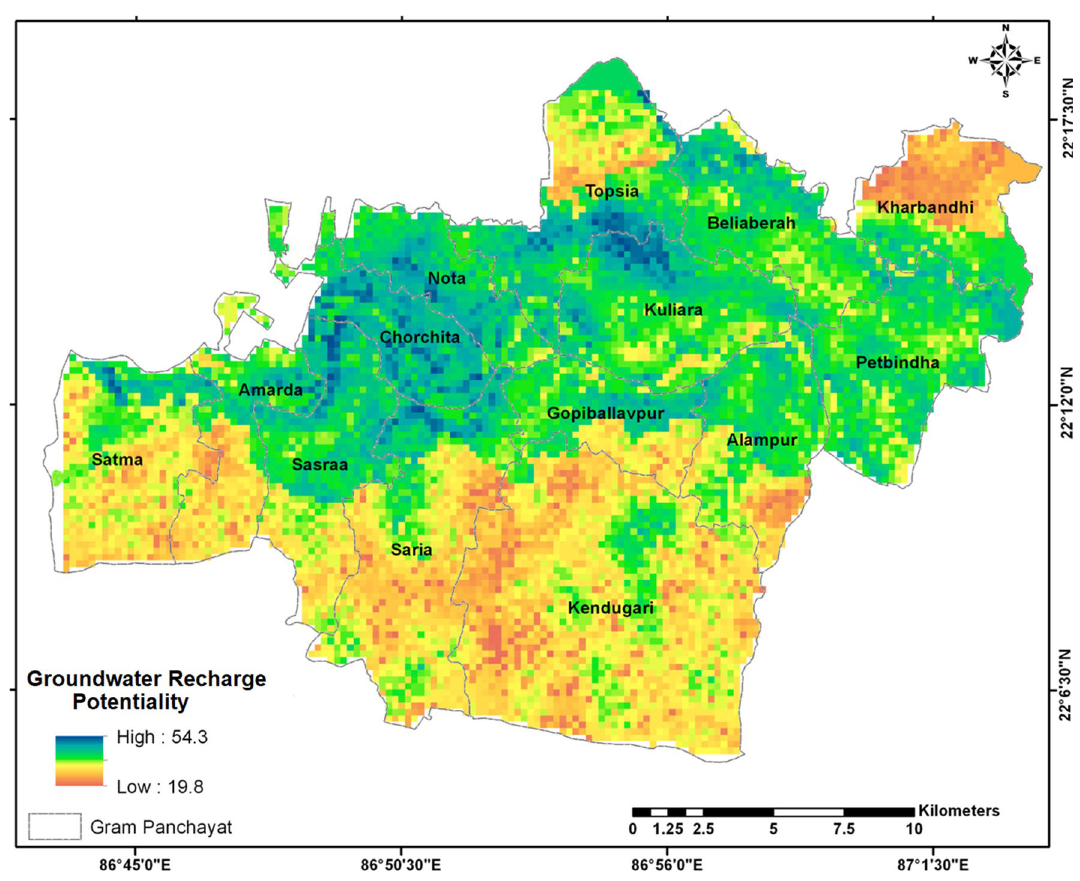
Fig. 5 Groundwater potential map Gopiballavpur block, Paschim Medinipur, West Bengal,